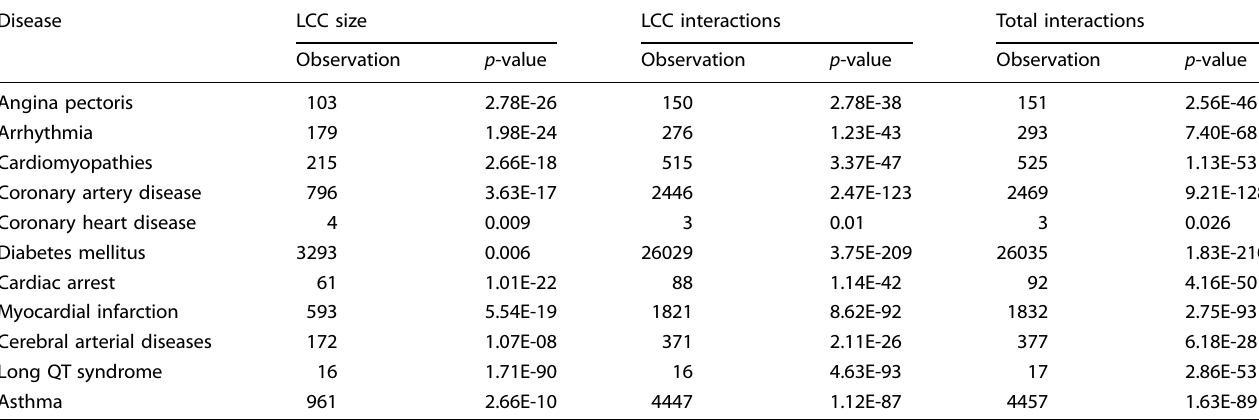
Table 1. Module search